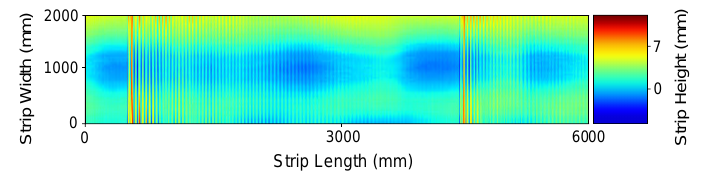
Figure 7. Raw optical flatness sensor data. (Color